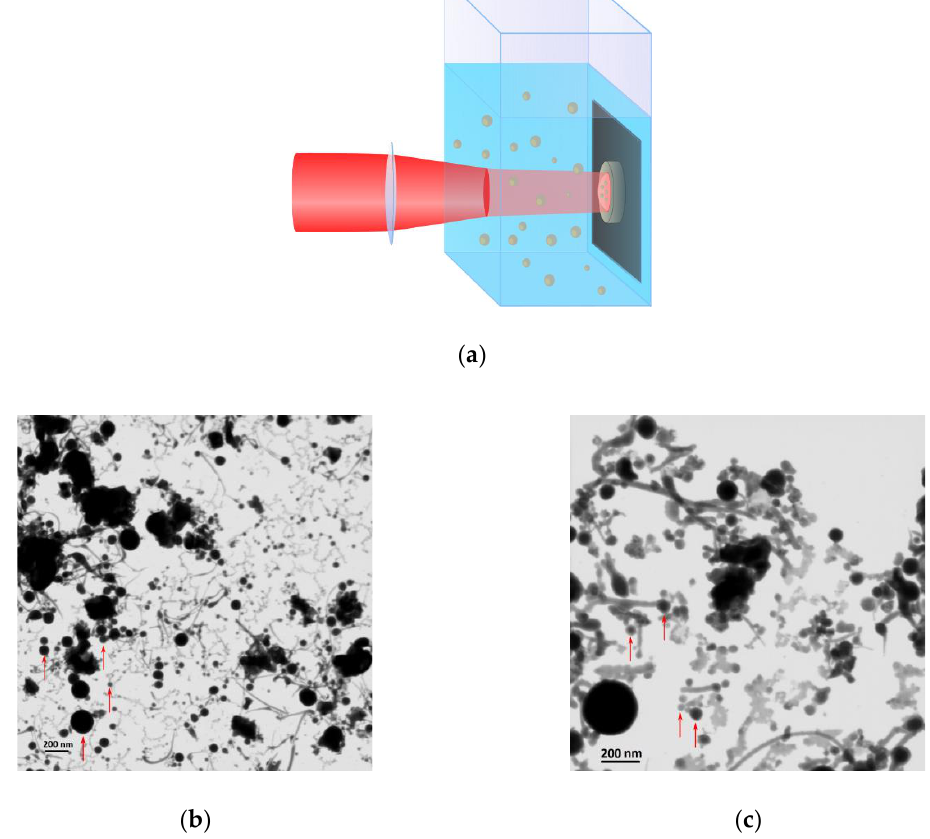
Figure 2. Laser ablation setup and results. ( a ) Schematic representation of the ablation geometry. Typical transmission electron microscopy (TEM) images of nanoparticles (NPs) obtained by laser ablation of the Sm oxide target with ( b ) 10 µJ and ( c ) 100 µJ pulse energies.